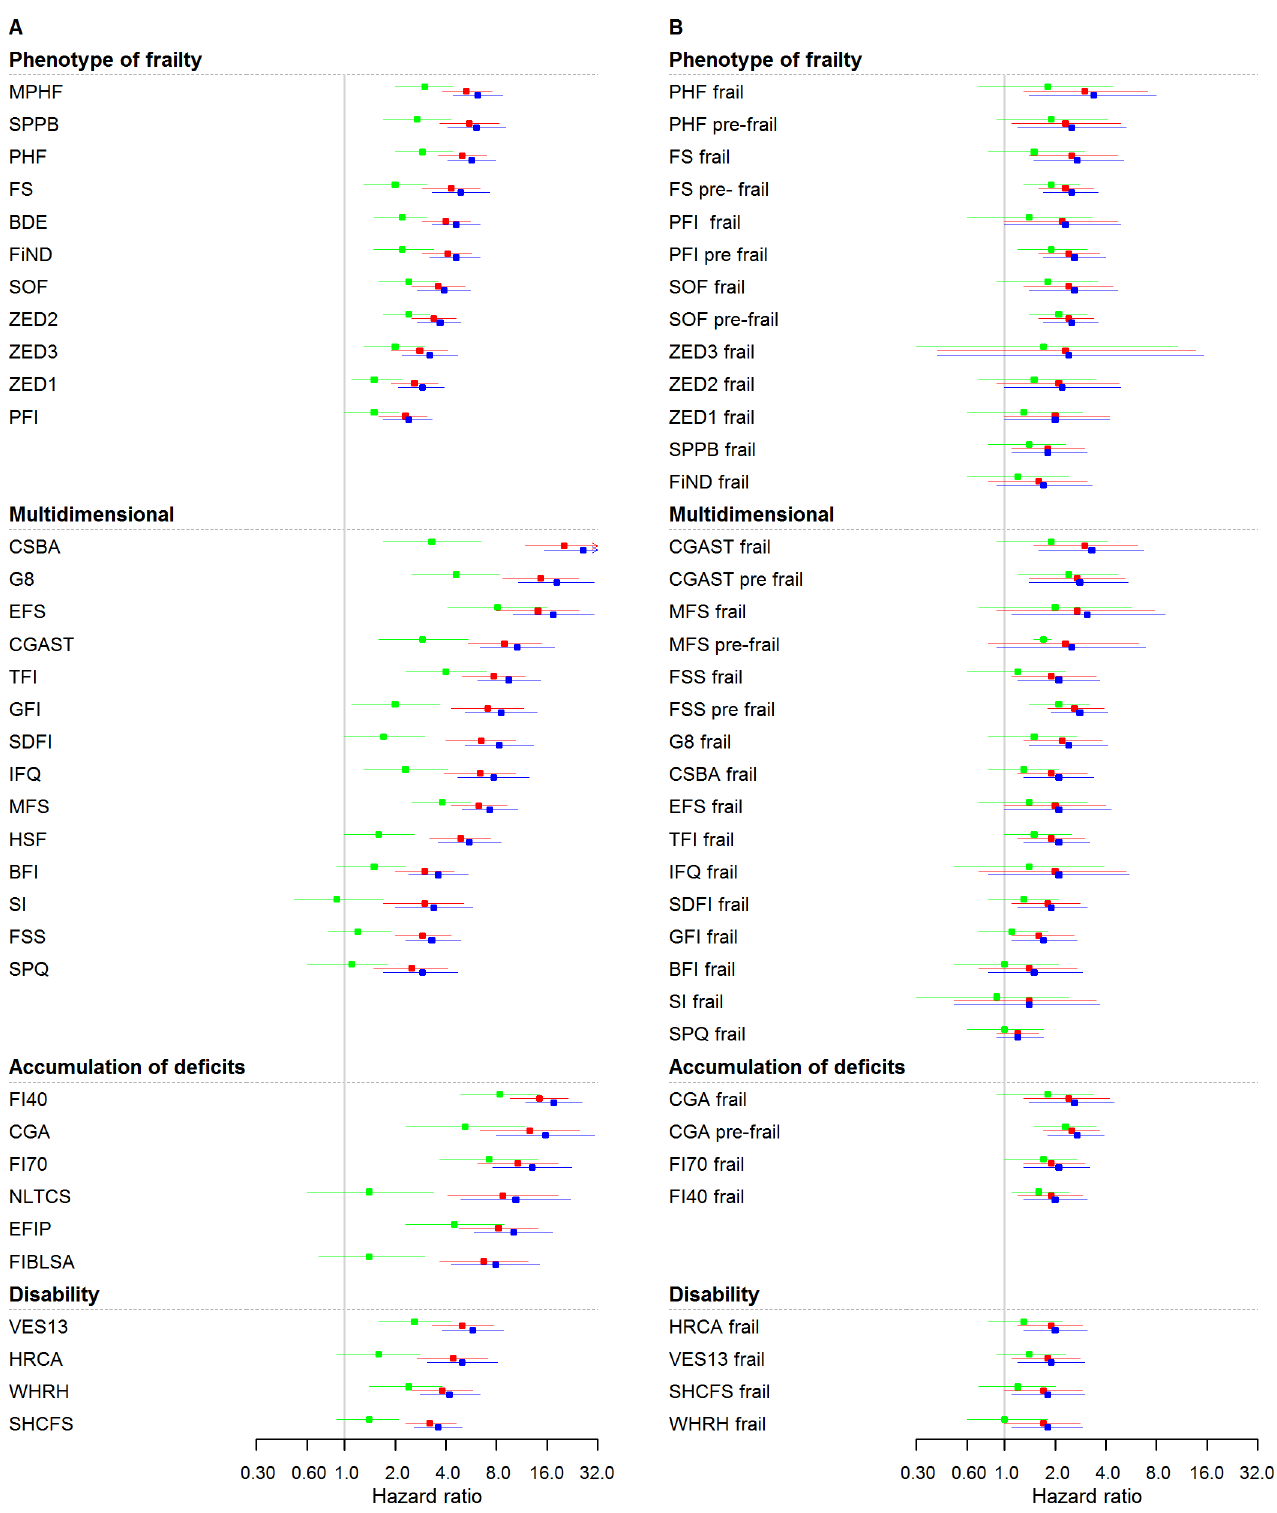
Fig 1. Mortality HRs of frailty scores ( n = 5,294): Continuous and cutoff analysis. (A) Left panel: continuous anaylsis; (B) right panel: categorical analysis. Models were fitted using age as timescale, with time 0 = age at entry of study and time 1 = age at event or censoring date. Model 1 in blue: adjusted by sex. Model 2 in red: Model 1 + smoking status, alcohol, and alcohol consumption. Model 3 in green: Model 2 + physical activity, BMI, diabetes, hypertension,